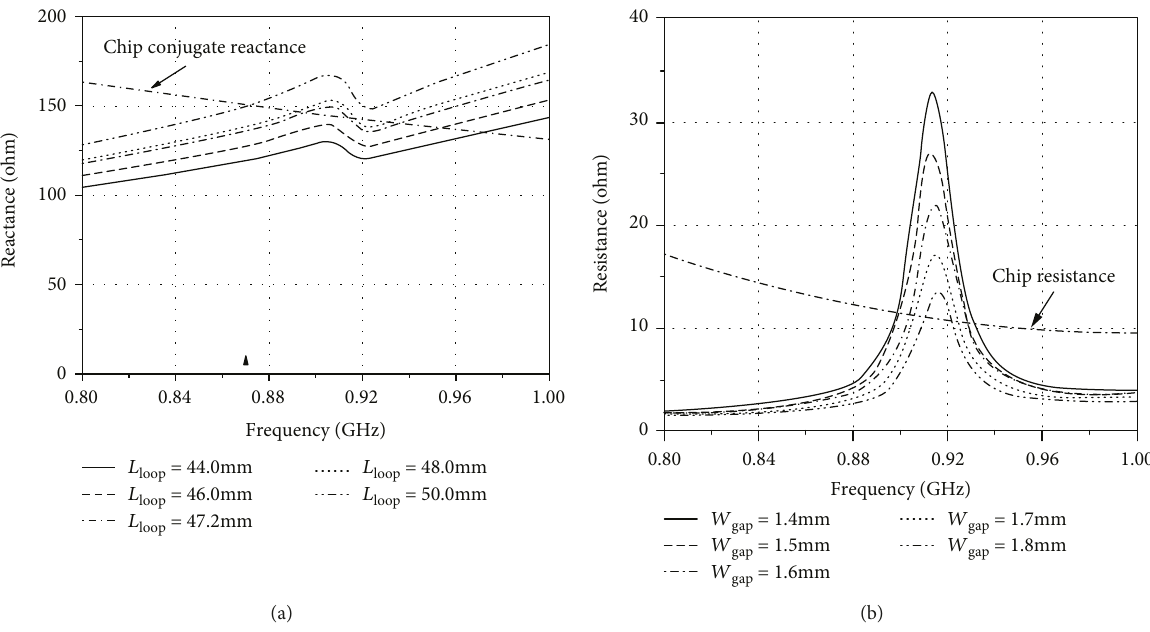
Figure 3: Impedance tuning and optimization of the antenna. (a) Input reactance curves of the antenna with di ff erent loop length L ( L = 78 mm, W = 30 mm, h = 3 mm, W ( L = 78 mm, W = 30 mm, h = 3 mm, W width W gap